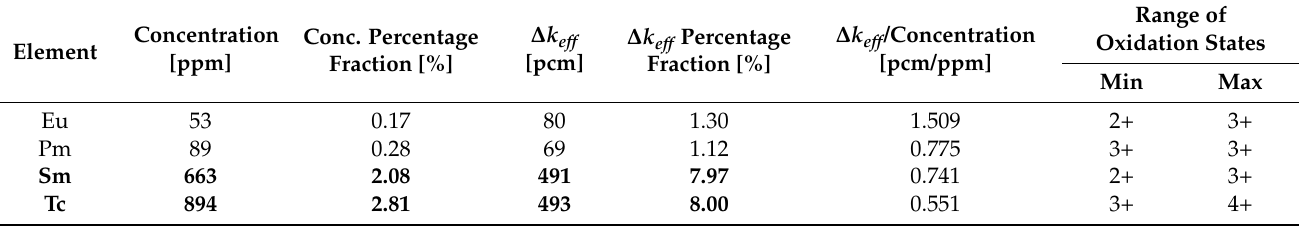
Table 1. Concentration of the leading fission product poison elements accumulated after a burnup of 100 GWd/tHM assessed through their correlated influence on the system criticality, with the most relevant elements marked in bold